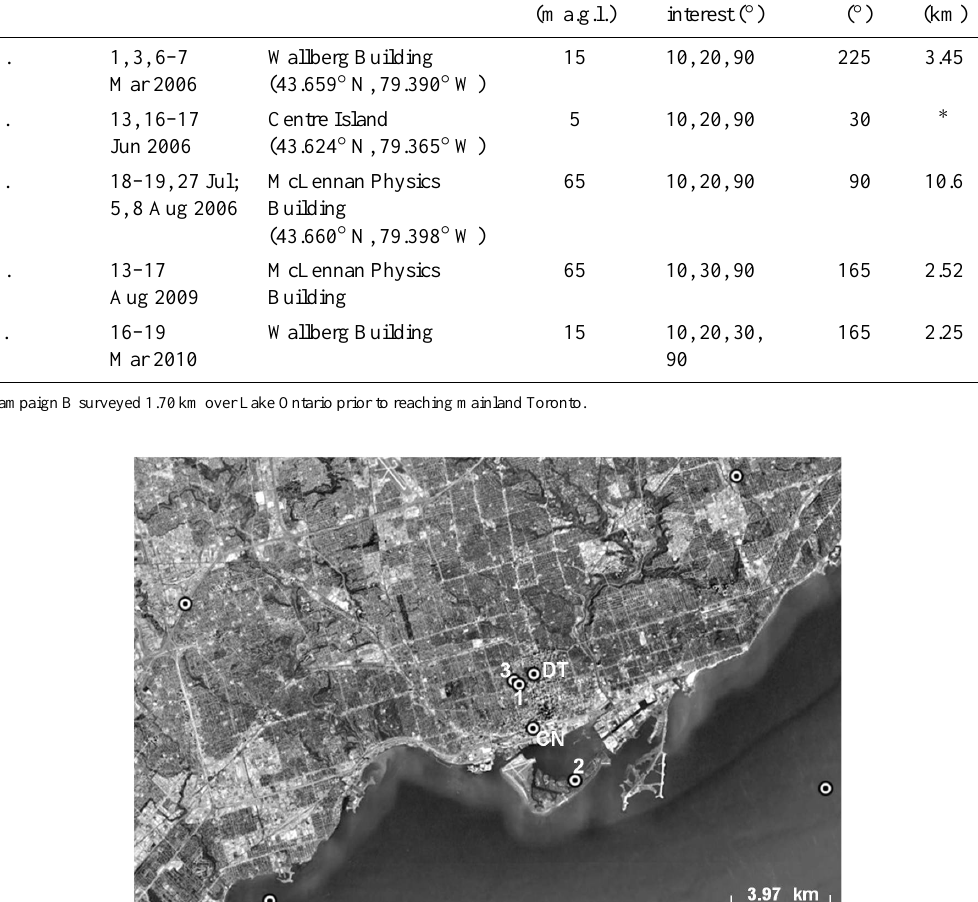
Table 2. Monitoring period and associated observation geometry for MAX-DOAS measurements. The horizontal distance from the MAX- DOAS instrument (at the azimuth angle surveyed) to Lake Ontario is provided in the “Mainland Toronto” column. Campaign Monitored Location Measurement Elevation Azimuth Mainland period height angles of angle Toronto (ma.g.l.) interest ( ◦ ) ( ◦ ) (km) 1, 3, 6–7 Wallberg Building 15 10, 20, 90 225